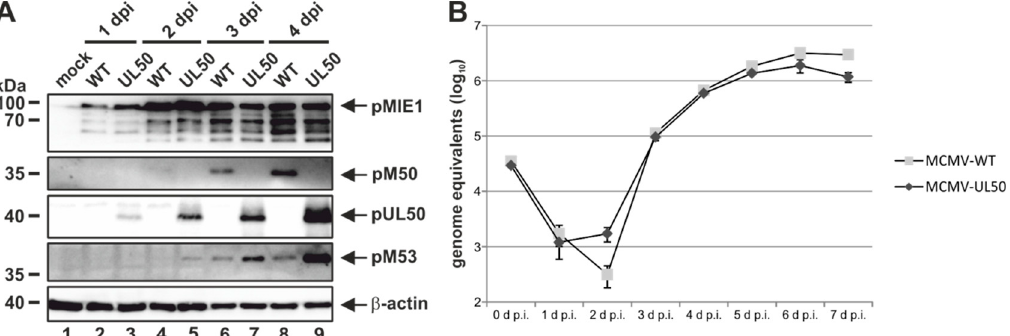
Figure 6. HCMV pUL50 mediates efficient viral protein expression and replication in chimeric MCMV. MEFs were infected with wild-type MCMW-WT and recombinant MCMV-UL50 at an (A) MOI of 1 or (B) MOI of 0.01. ( A ) At various time points, cells were lysed and protein expression was analyzed using protein-specific antibodies. ( B ) Viral supernatants were harvested at the indicated time points and viral genome equivalents released into the supernatant were determined by murine IE1-specific quantitative real-time PCR (qPCR). Each infection was performed in triplicate and mean values and standard deviations are shown.